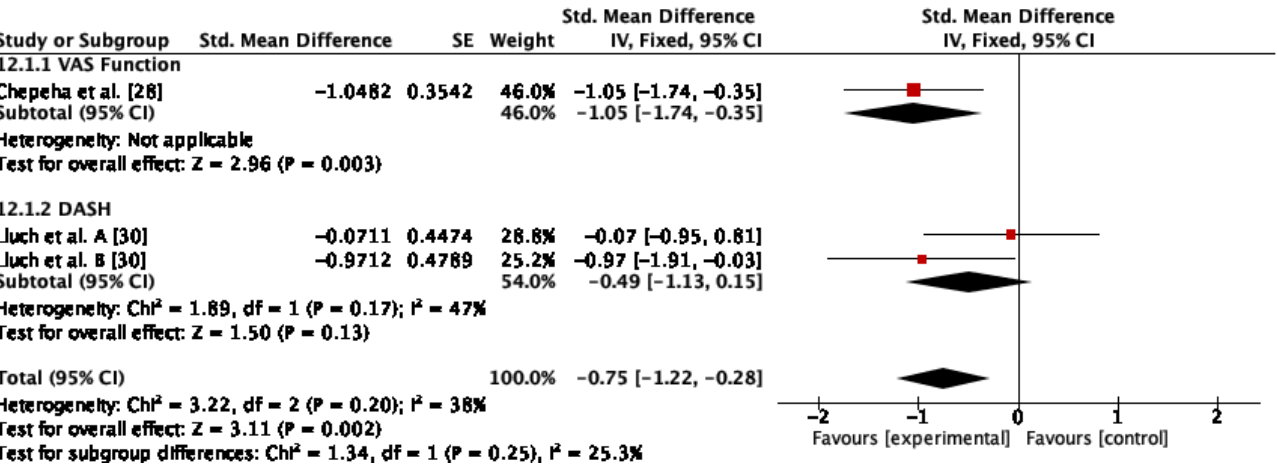
Figure 9. Forest plot of physical function for conservative therapy versus control/sham and con- servative therapy versus other conservative therapy. Lluch et al. A. compared manual therapy ver- sus control intervention. Lluch et al. B compared the manual contact versus control intervention.